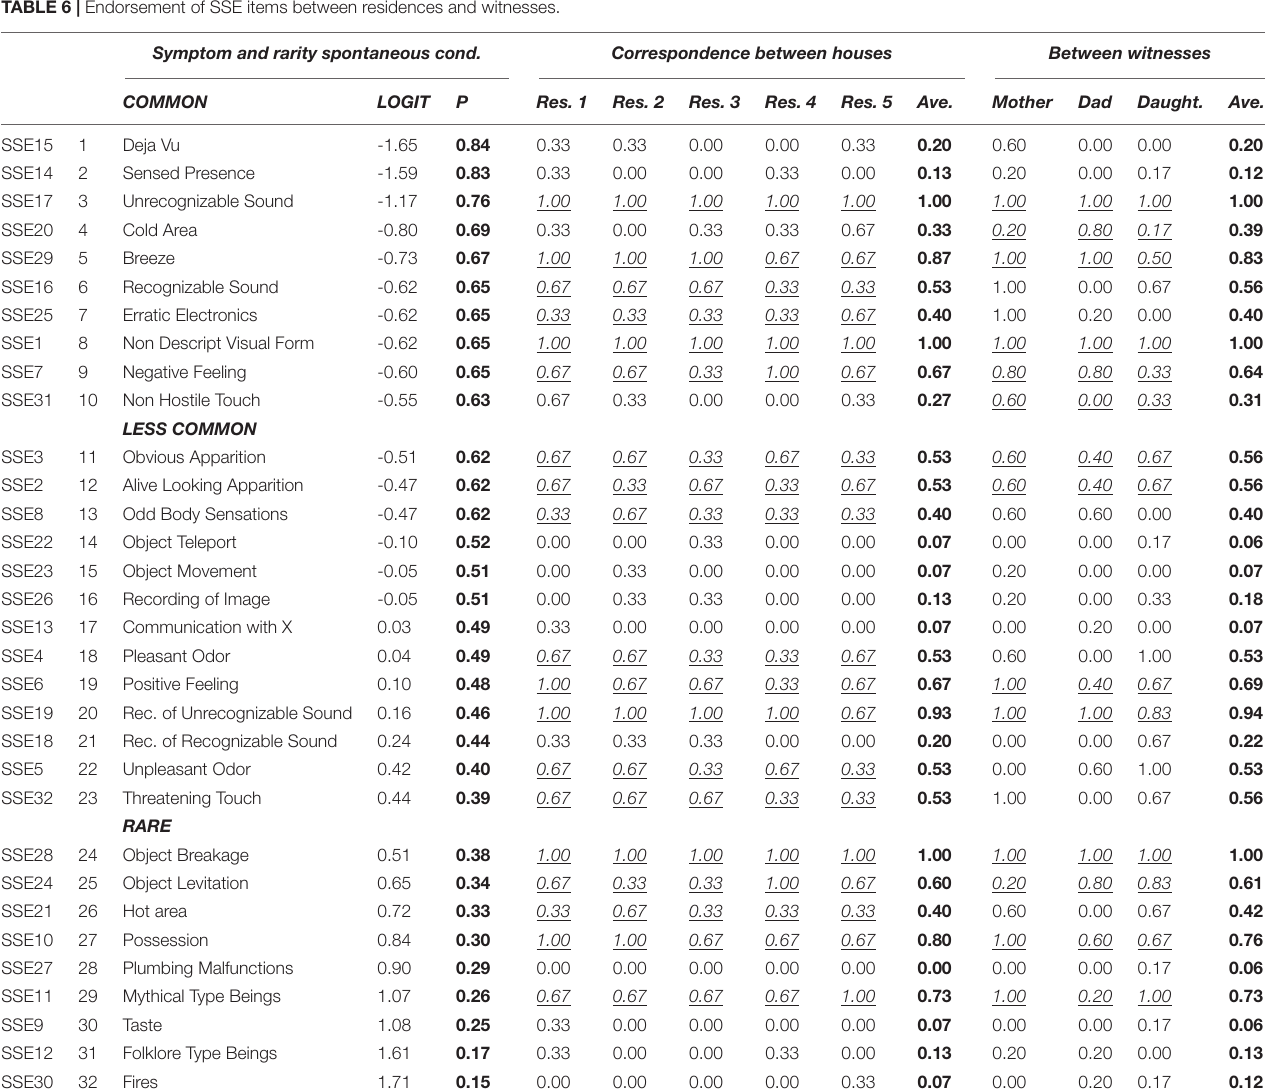
TABLE 6 | Endorsement of SSE items between residences and witnesses. Symptom and rarity spontaneous